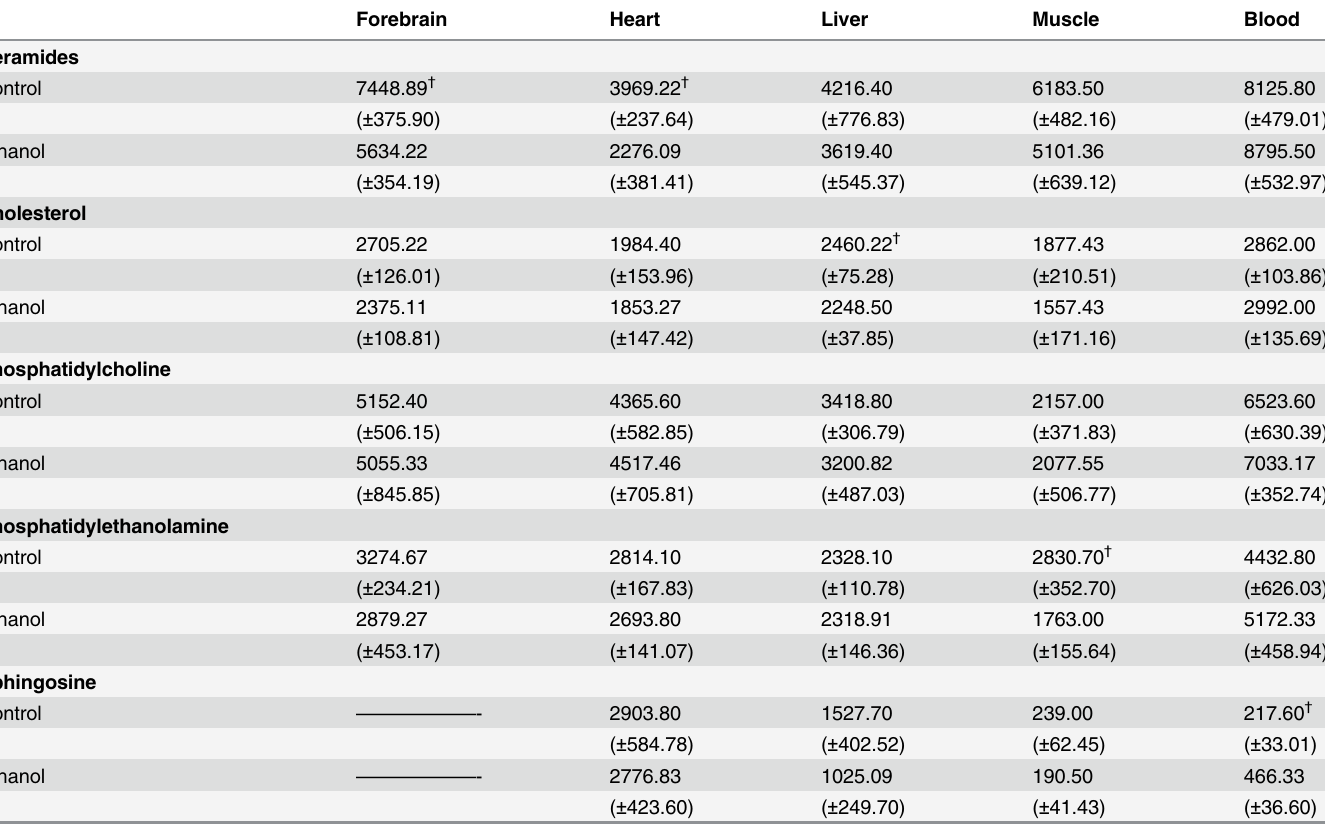
Table 1. Mean ( ± SEM) Optical Density Values by Lipid and Treatment Condition for Each Tissue Type. Forebrain Heart Liver Muscle